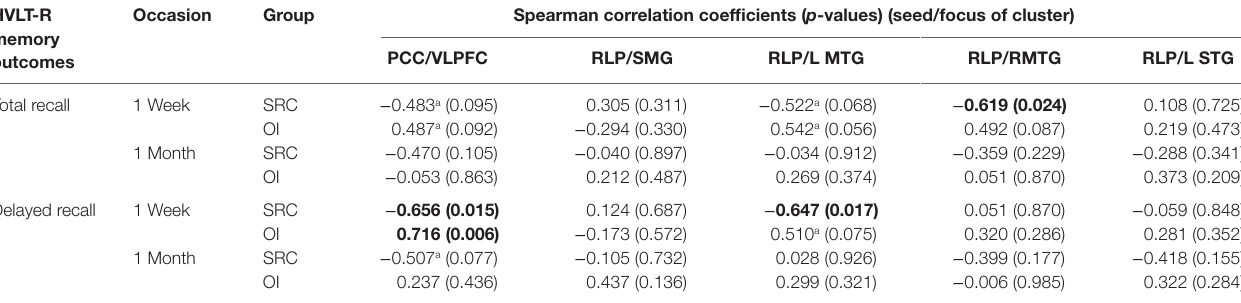
Table 4 | Within group spearman correlations between functional connectivity and memory outcomes on